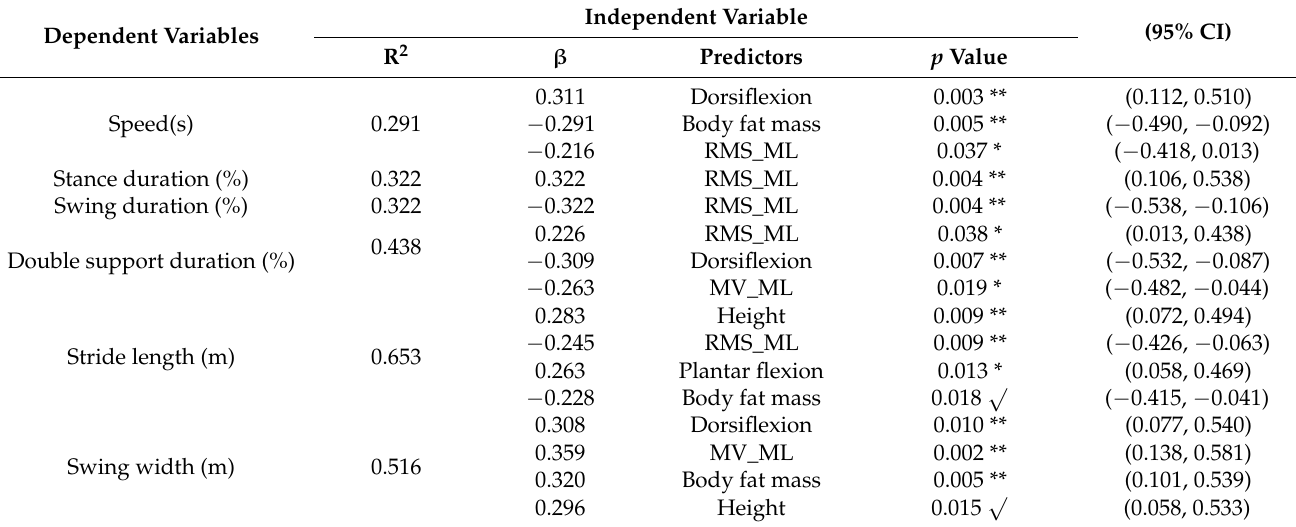
Table 3. Summary of results of stepwise regression analysis of gait performance in the elderly ( n = 78).